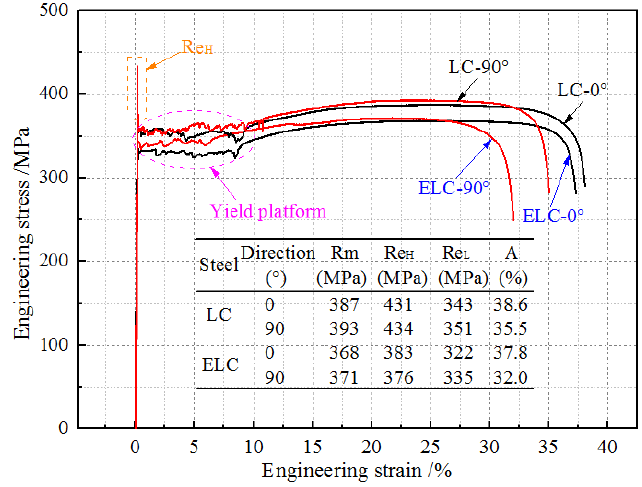
Figure 7. Engineering stress-strain curves and tensile properties of different C content. Table 3. r value and n value of different C